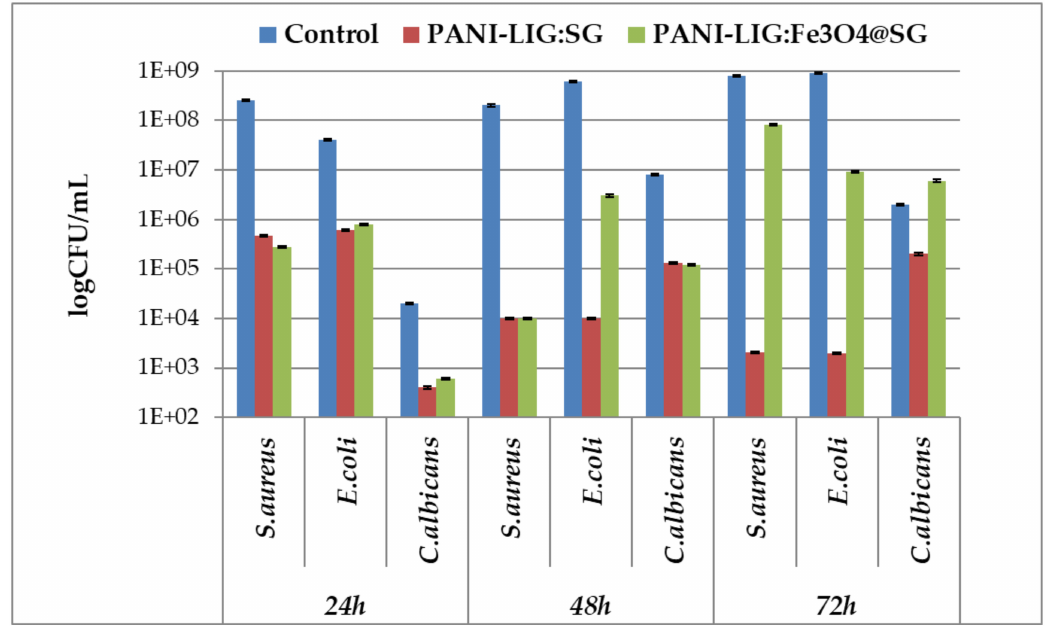
Figure 10. Colony-forming units (CFU)/mL values for Staphylococcus aureus , Escherichia coli , and Candida albicans biofilms after 24, 48, and 72 h of incubation in the presence of control (bare substrates) and MAPLE nano-modified